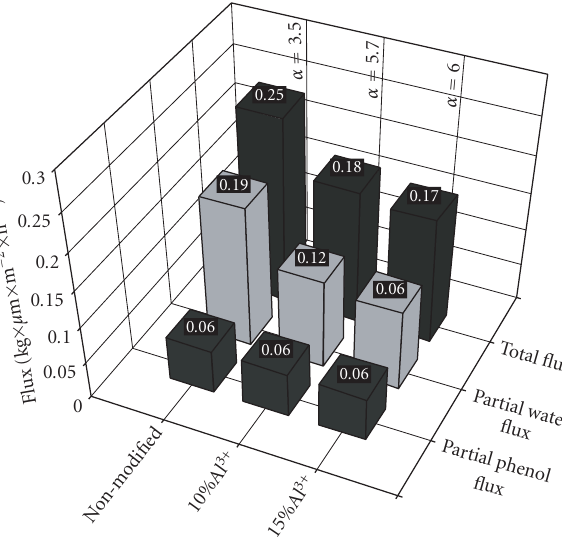
Figure 10: E-MAA 38 copolymer cross-linked covalently with 10% 4MPD (2,3,5,6-tetramethyl-1,4-phenylene diamine), 10% GDE (glycerine diglycidylether) and ionically using 10% and 15% Al 3+ , feed concentration 8wt% phenol, membrane temperature 313K.